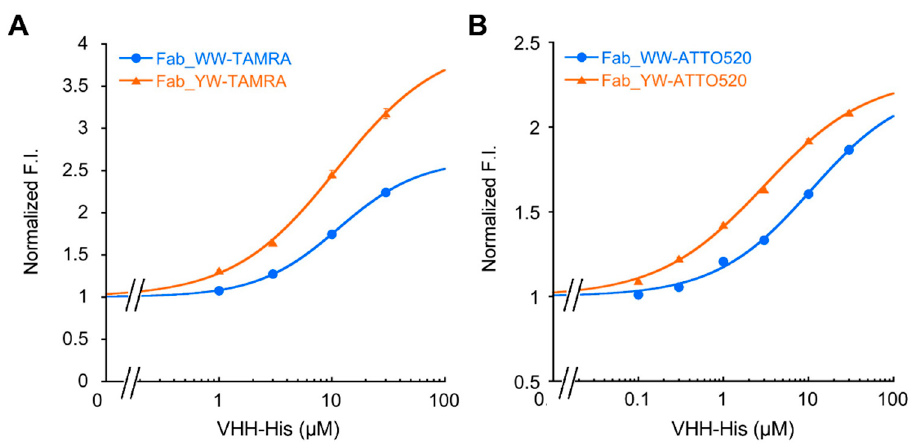
Figure 5. Responses of Q-bodies to His-tagged protein. Dose-response curve for spiked C-terminal His6-tagged nanobody detected by TAMRA- ( A ) and ATTO520- ( B ) labeled Fab-type Q-bodies in 50% M9 culture medium after cultivation with Brevibacillus choshinensis HPD31. Error bars indicate ±1 SD (n = 3).